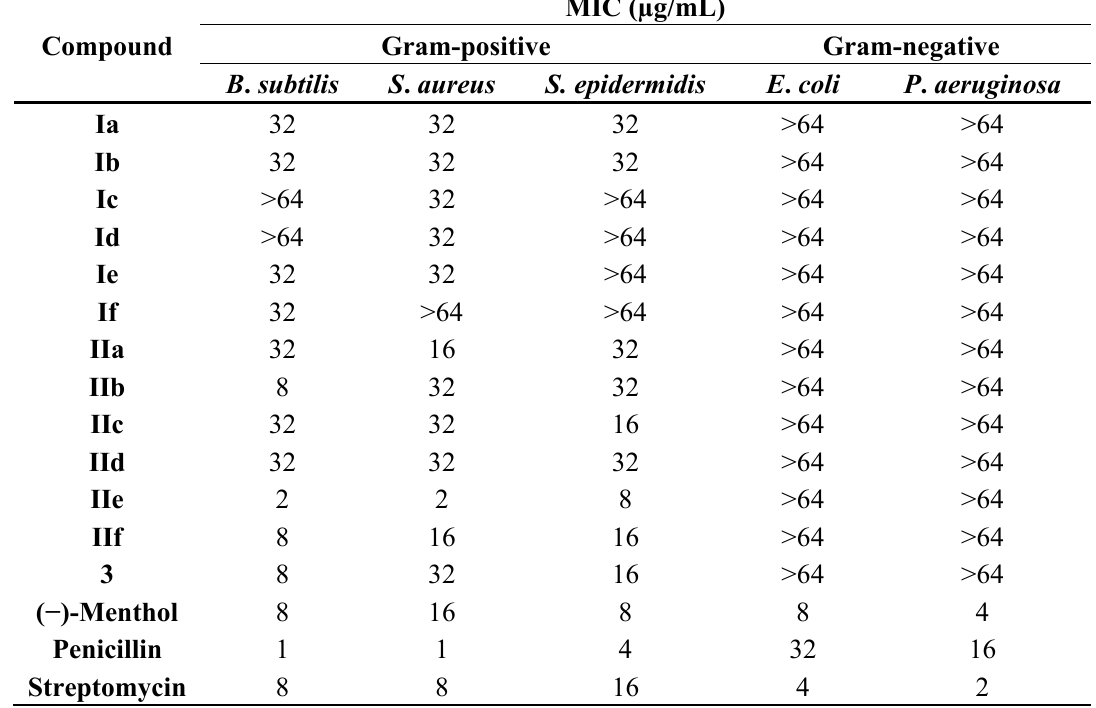
Table 1. MIC values (µg/mL) of the tested compounds against selected bacterial strains.